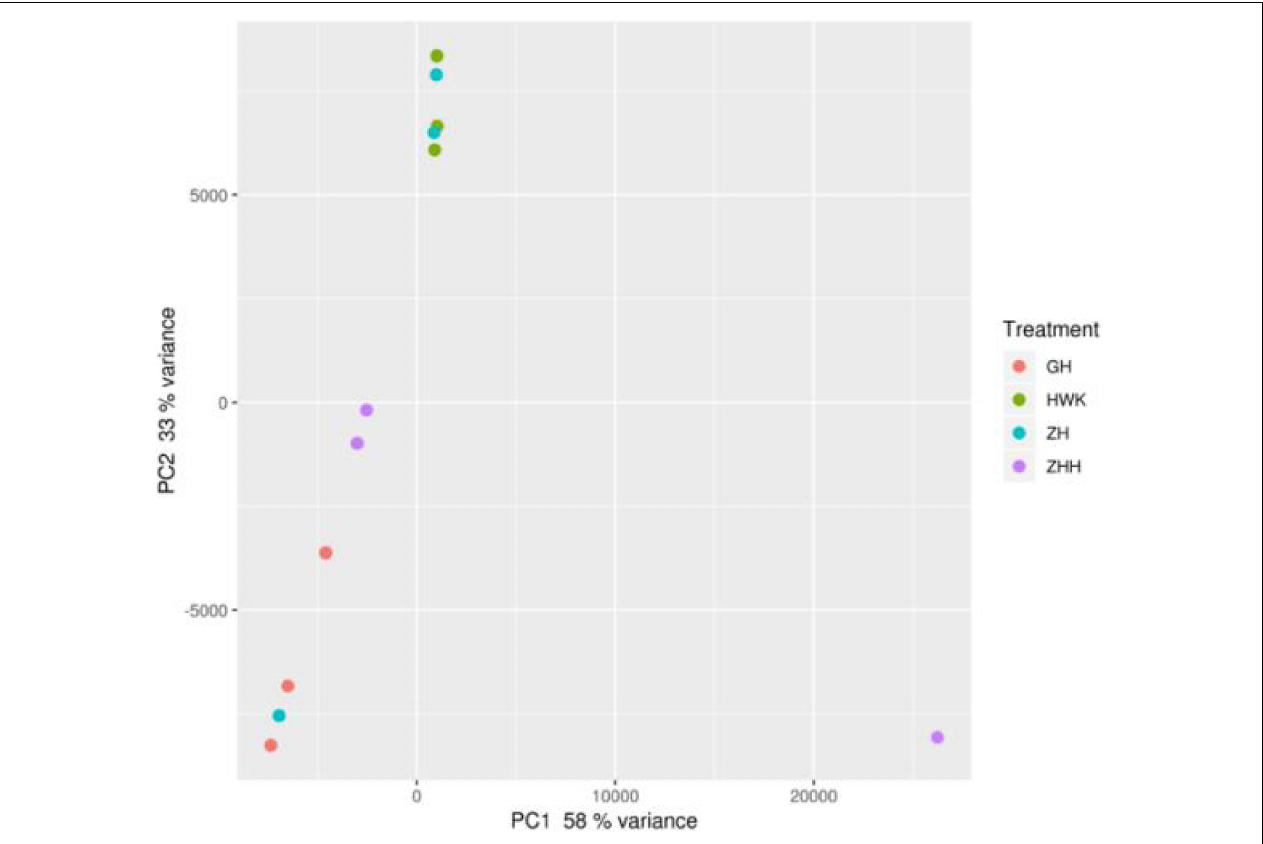
FIGURE 12 | PCA of the lung microbiome of chickens. HWK (control group); GH (infection group); ZH (treatment group); ZHH (post-treatment